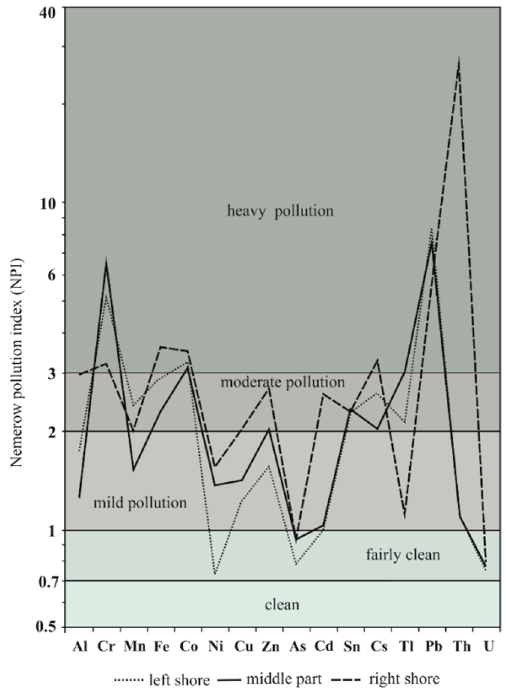
Figure 5. Nemerow pollution index (NPI) in water of the Angara River source.